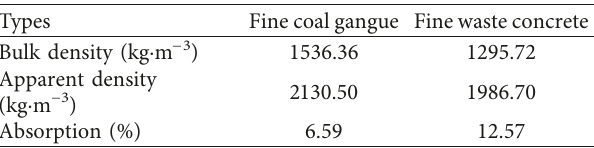
Table 2: Bulk density and apparent density of the coal gangue and waste concrete aggregate.